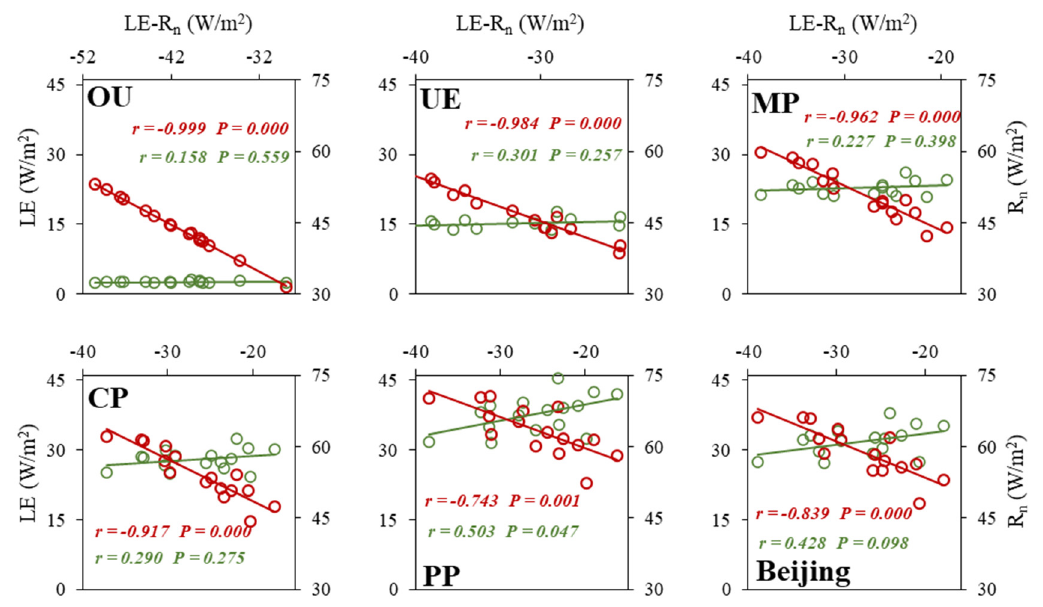
Figure 10. Relationships between latent heat flux and net radiation (LE − R n ) and LE, and R n under various land use types in Beijing from 2000 to 2015. The red dots and lines are the scatter plot of LE − R n and R n ; the green dots and lines are the scatter plot of LE − R n and